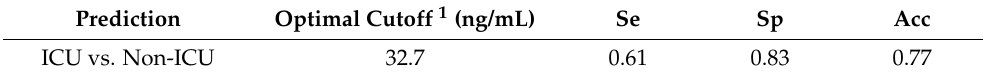
Table 3. Test performance of sE-selectin for prediction of ICU